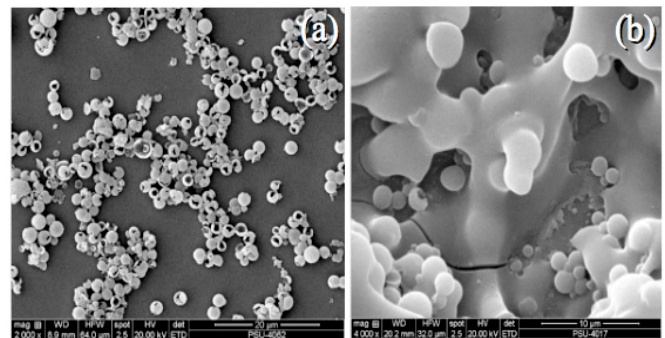
Figure 2. Scanning electron microscopic images of MIP after reducing the polymer sizes by 1 × 10 3 bars high pressure homogenizer ( a ) and coated on screen printed carbon electrode surface ( b ).